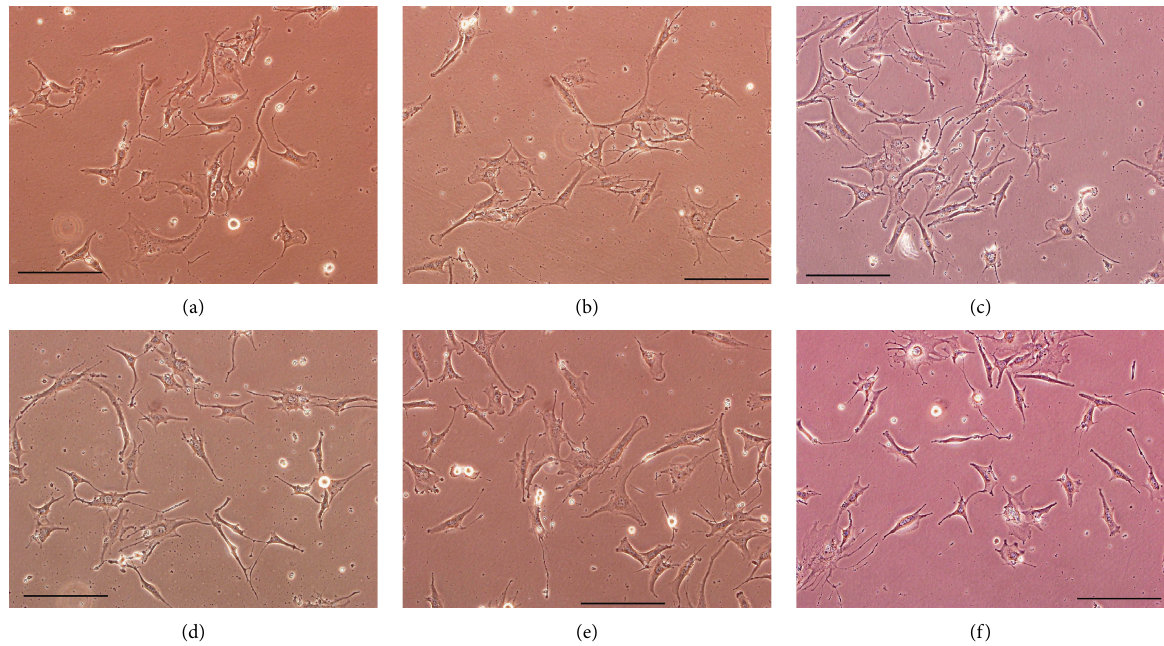
Figure 2: Morphological analysis of MIO-M1 M¨uller cells in different experimental conditions. (a) CTR 24h; (b) 24h CoCl2; (c) 24h CoCl 2 +24h REC; (d) CTR 48h; (e) 48h CoCl2; and (f) 48 h CoCl2+24h REC. Black bar: 100 μ